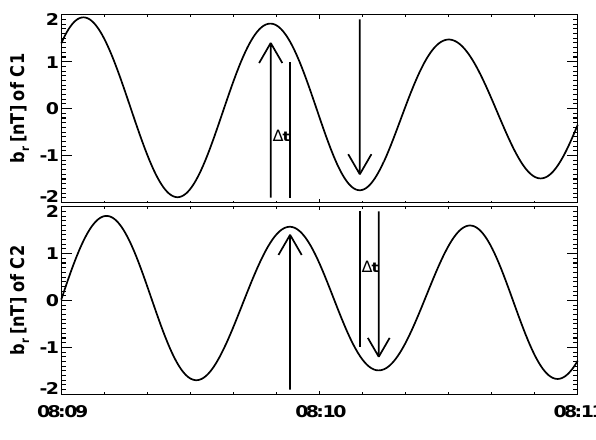
Fig. 8. Time series of the radial magnetic field oscillation of space- craft C1 and